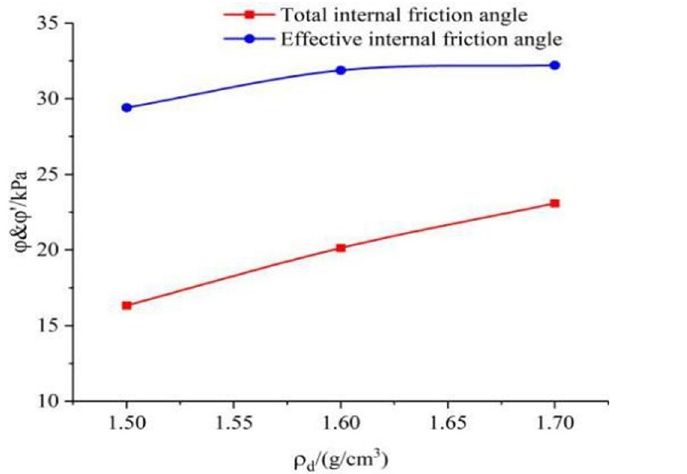
Fig 11. The curve of shear strength index c with dry density.